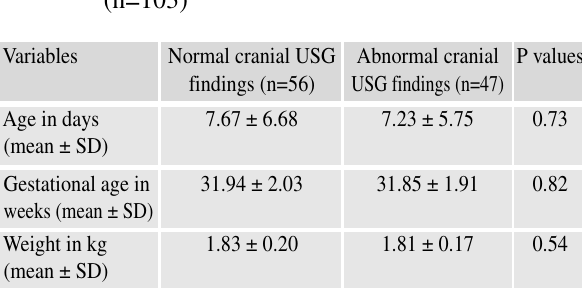
Table I: Distribution of subjects according to age, gestational age and weight in both groups